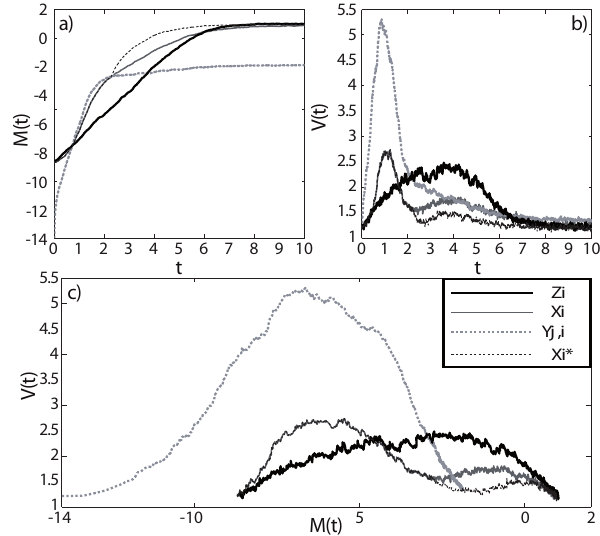
Fig. 8. Growth of perturbations in the two-scale model ( x i ; y j,i ) with strong coupling ( h =1) versus the single-scale model ( z i ) and the single-scale model with an equivalent noise ( x ∗ ): (a) temporal i evolution of the M-component of the growth of perturbations, (b) temporal evolution of the V-component, (c) MVL